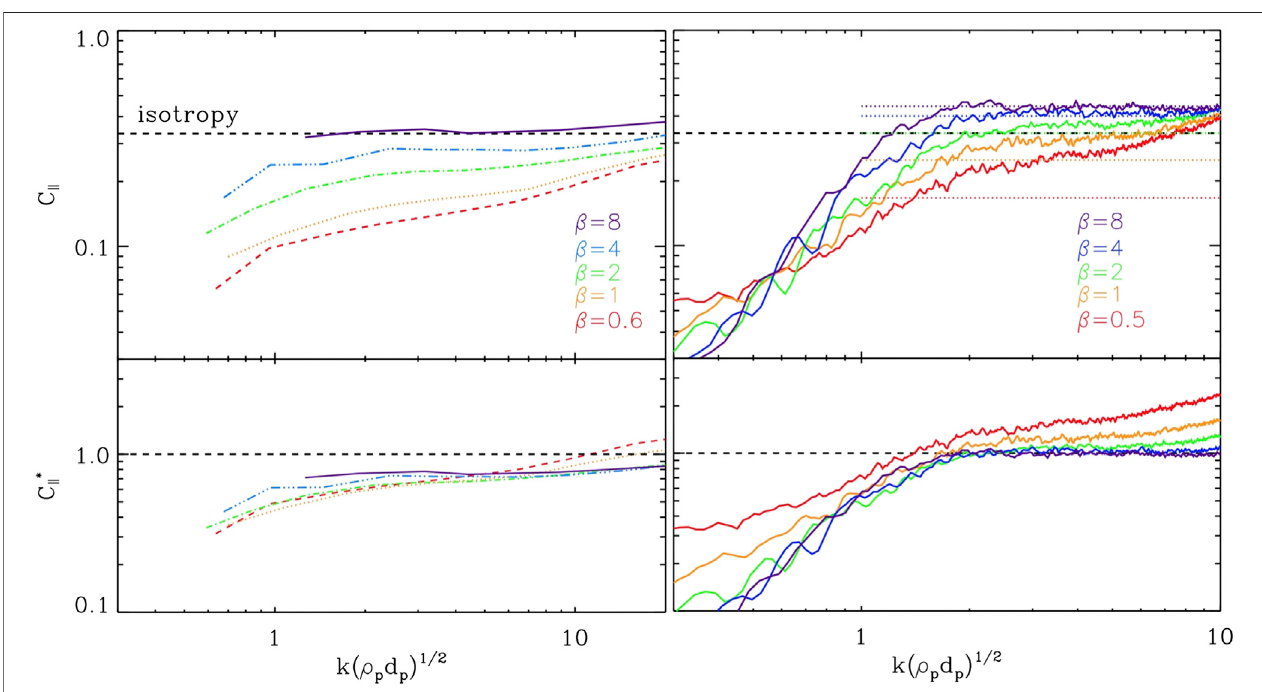
(cid:9)(cid:9)(cid:9)(cid:9) (cid:11) ; in the bottom panels, C (cid:3) is normalized to the theoretical d p ρ p